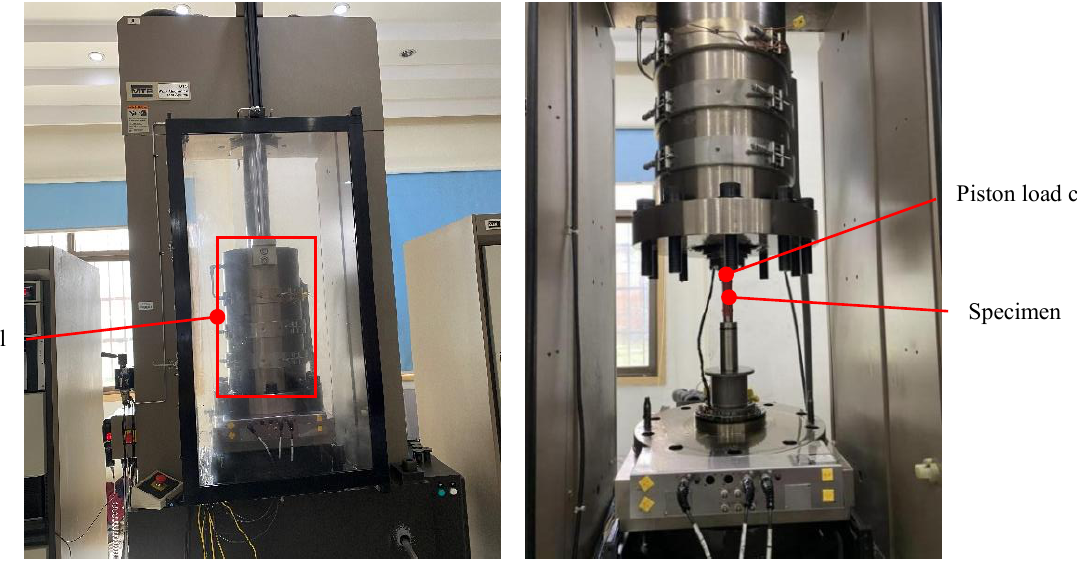
Figure 6. High performance rock triaxial test system MTS 815.